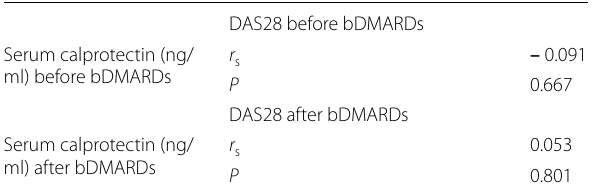
Table 2 Correlation between DAS28 and serum calprotectin